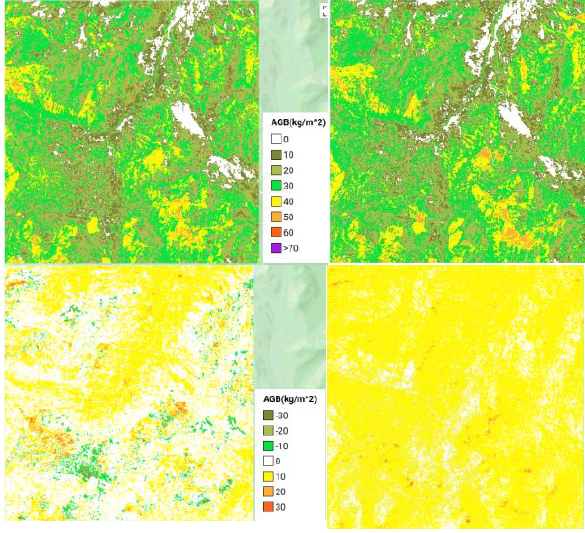
Figure 4. La Fusta area in 2002 – above-ground biomass estimated using eq. 1 with Landsat 7 ETM+ (top left) and Landsat 5 TM (top right) and difference map from single year (bottom left) and from composite (bottom right).